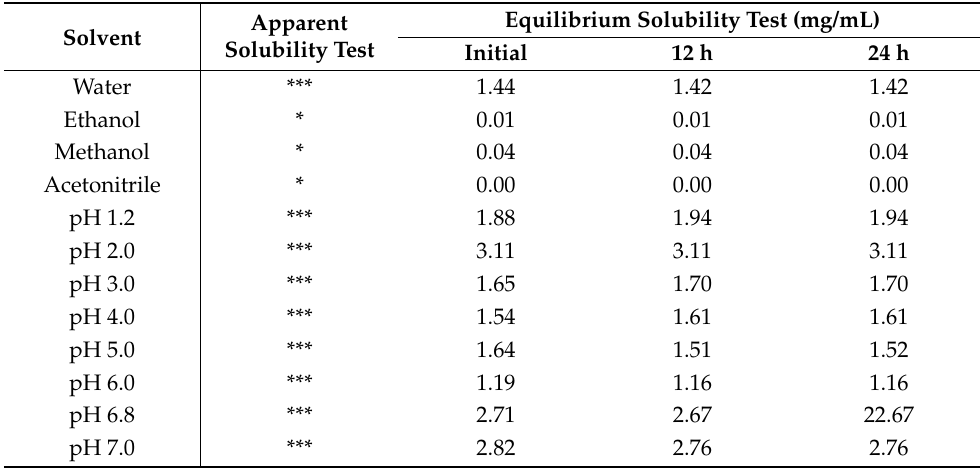
Figure 5. Changes in the appearance of ( a ) sitagliptin phosphate monohydrate and ( b ) dapagliflozin propanediol hydrate in various solvents (apparent solubility test method). Table 3. Solubility of sitagliptin phosphate monohydrate in various solvents.